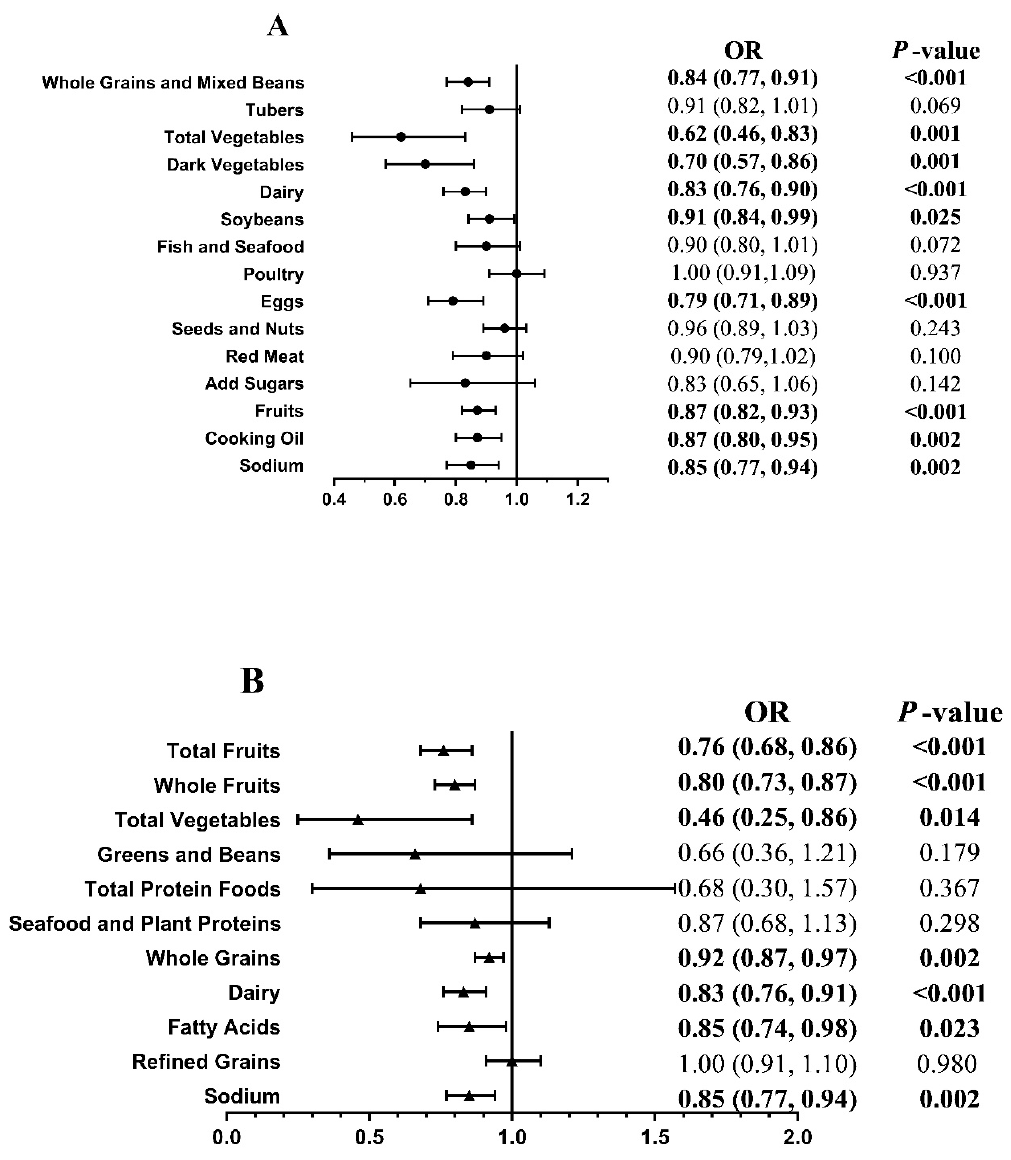
Figure 1. Association of the score for each component of the CHEI ( A ) and HEI-2015 ( B ) with the risk of cardiovascular complications between case and control. We adjusted ORs for age, body mass index, marital status, physical activity, education level, smoker status, alcohol consumption, tea-drinking status, hypertension status, dyslipidemia status, T2D duration, antidiabetic medication use, medical nutrition therapy knowledge, and nonalcohol energy. Cases, T2D with newly diagnosed CVD. Controls, T2D-only controls without a diagnosis of CVD. CHEI, the Chinese Healthy Eating Index. HEI-2015, the Healthy Eating Index-2015. Fatty acids, ratio of total unsaturated fatty acids (poly- and monounsaturated fatty acids (PUFAs and MUFAs)) to saturated fatty acids (SFAs). Statistically significant results are presented in bold.